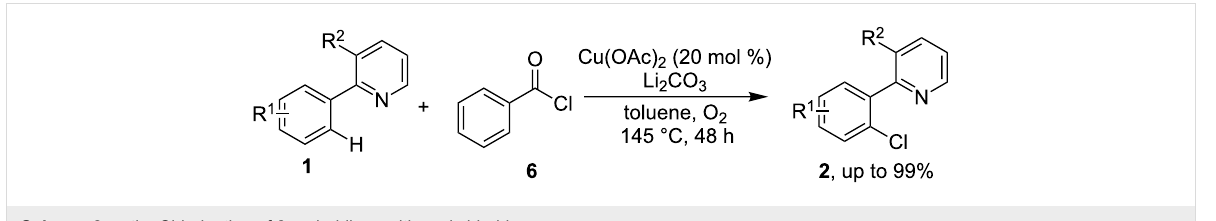
Scheme 2: ortho -Chlorination of 2-arylpridines with acyl chlorides.